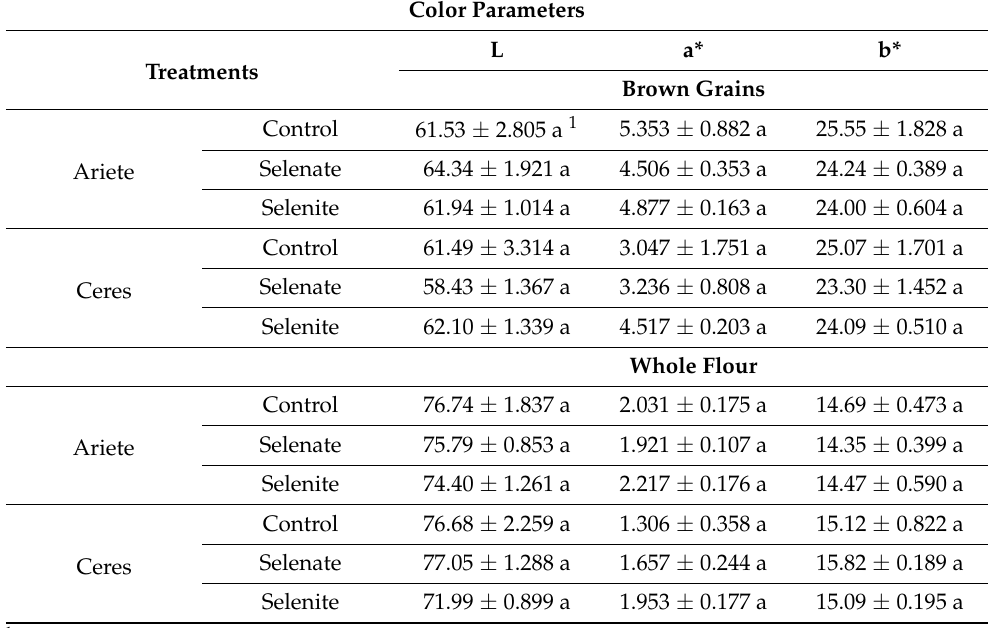
Table 1. Average of color parameters ± standard error ( n = 4) in brown rice grains and respective flours in Ariete and Ceres varieties L. (brightness), a* (red and green transitions) and b* (yellow and blue transitions).